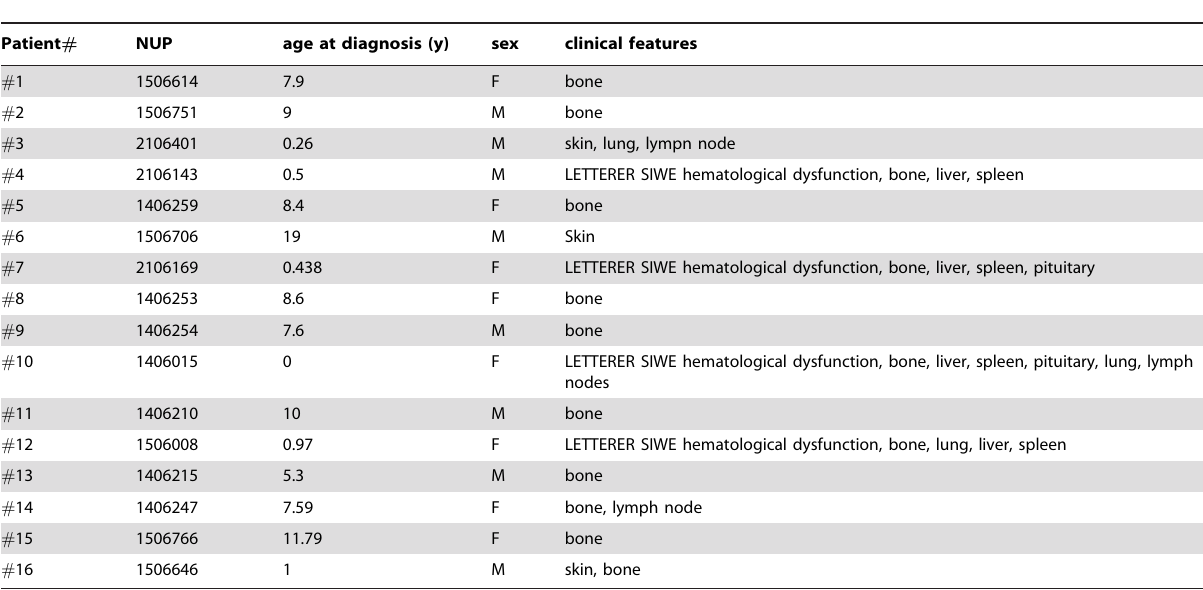
Table 1. Age, sex, and clinical characteristics of patients 1 to